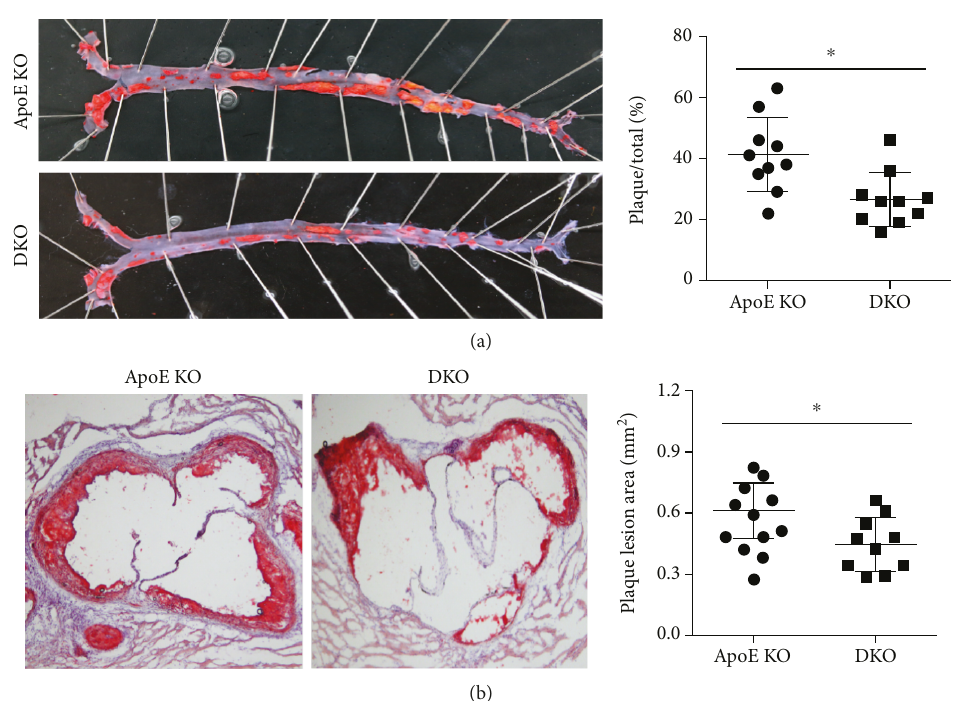
Figure 1: The atherosclerotic plaque area of the ApoE-/- mouse and ApoE-/- IL-12p35-/- mouse groups. The atherosclerotic plaque area of (a) aortic trees (10x) and (b) aortic roots (10x) in these two groups was detected by oil red O staining. ApoE KO=ApoE-/-, DKO=ApoE-/- IL-12p35-/-; N = 10 for each group. ∗ P < 0 05 . Table 2: Lipid pro fi le of serum and body weight of ApoE-/- and ApoE-/- IL-12p35-/- mice. ApoE -/- ApoE -/- IL-12p35